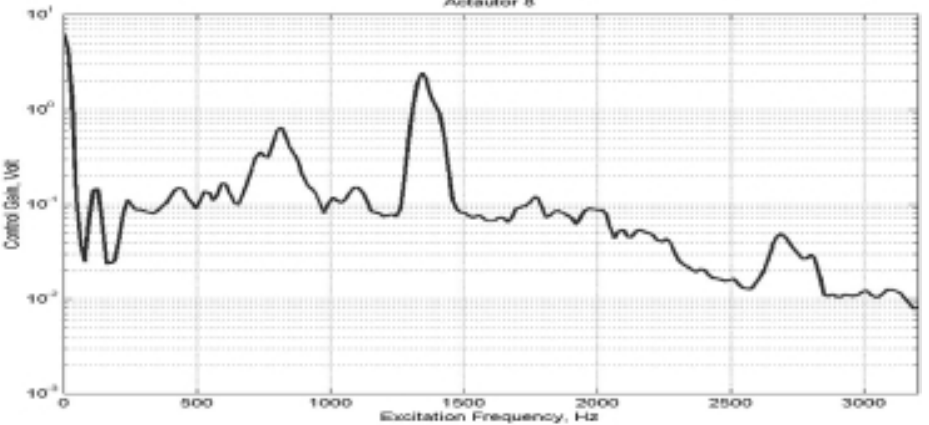
Fig. 14. The control voltage applied to the upper control